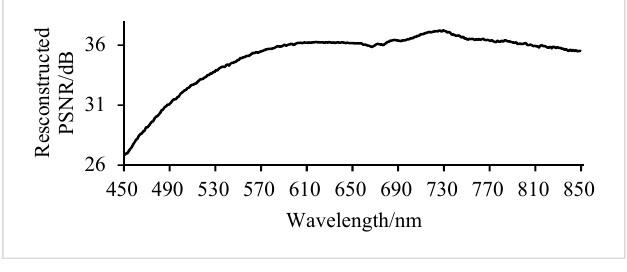
Figure 7. Reconstructed PSNR of each band at a sampling rate of 0.5 bpp.